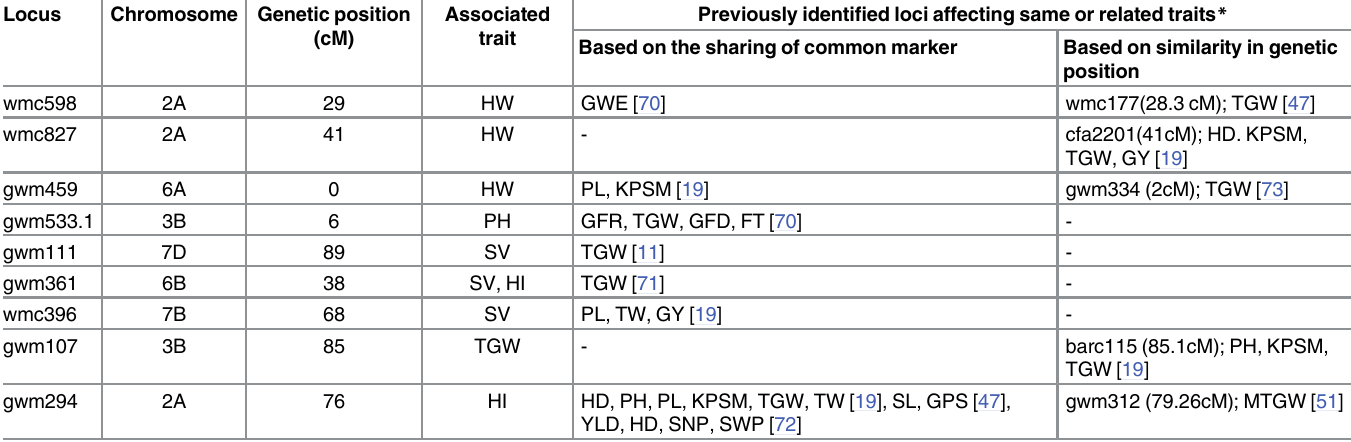
Table 3. List of the 10 most valuable (significant after FDR) MTAs involving 9 SSR markers that were detected during the present study using SLST approach and were also previously reported to affect related traits. Locus Chromosome Genetic position Associated Previously identi fi ed loci affecting same or related traits * (cM) trait Based on the sharing of common marker Based on similarity in genetic